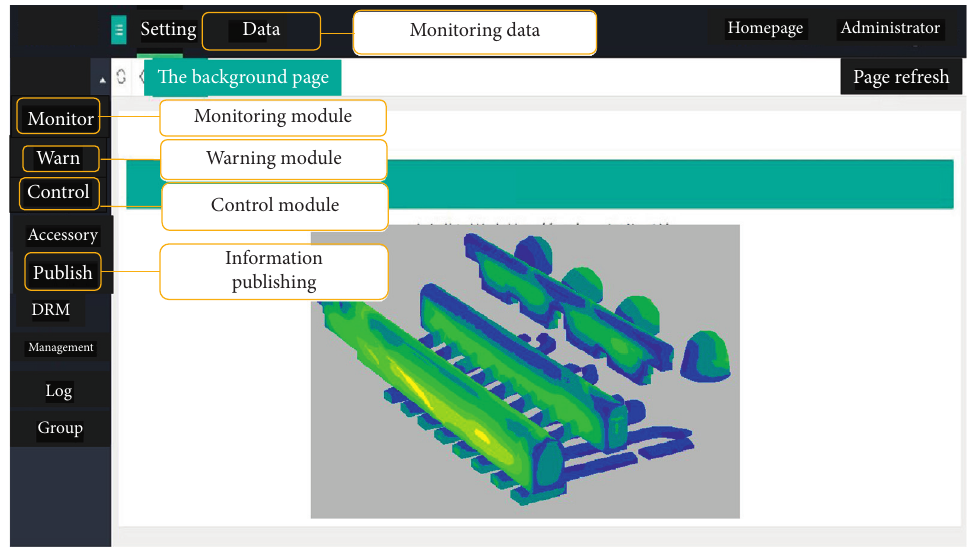
Figure 6: Control